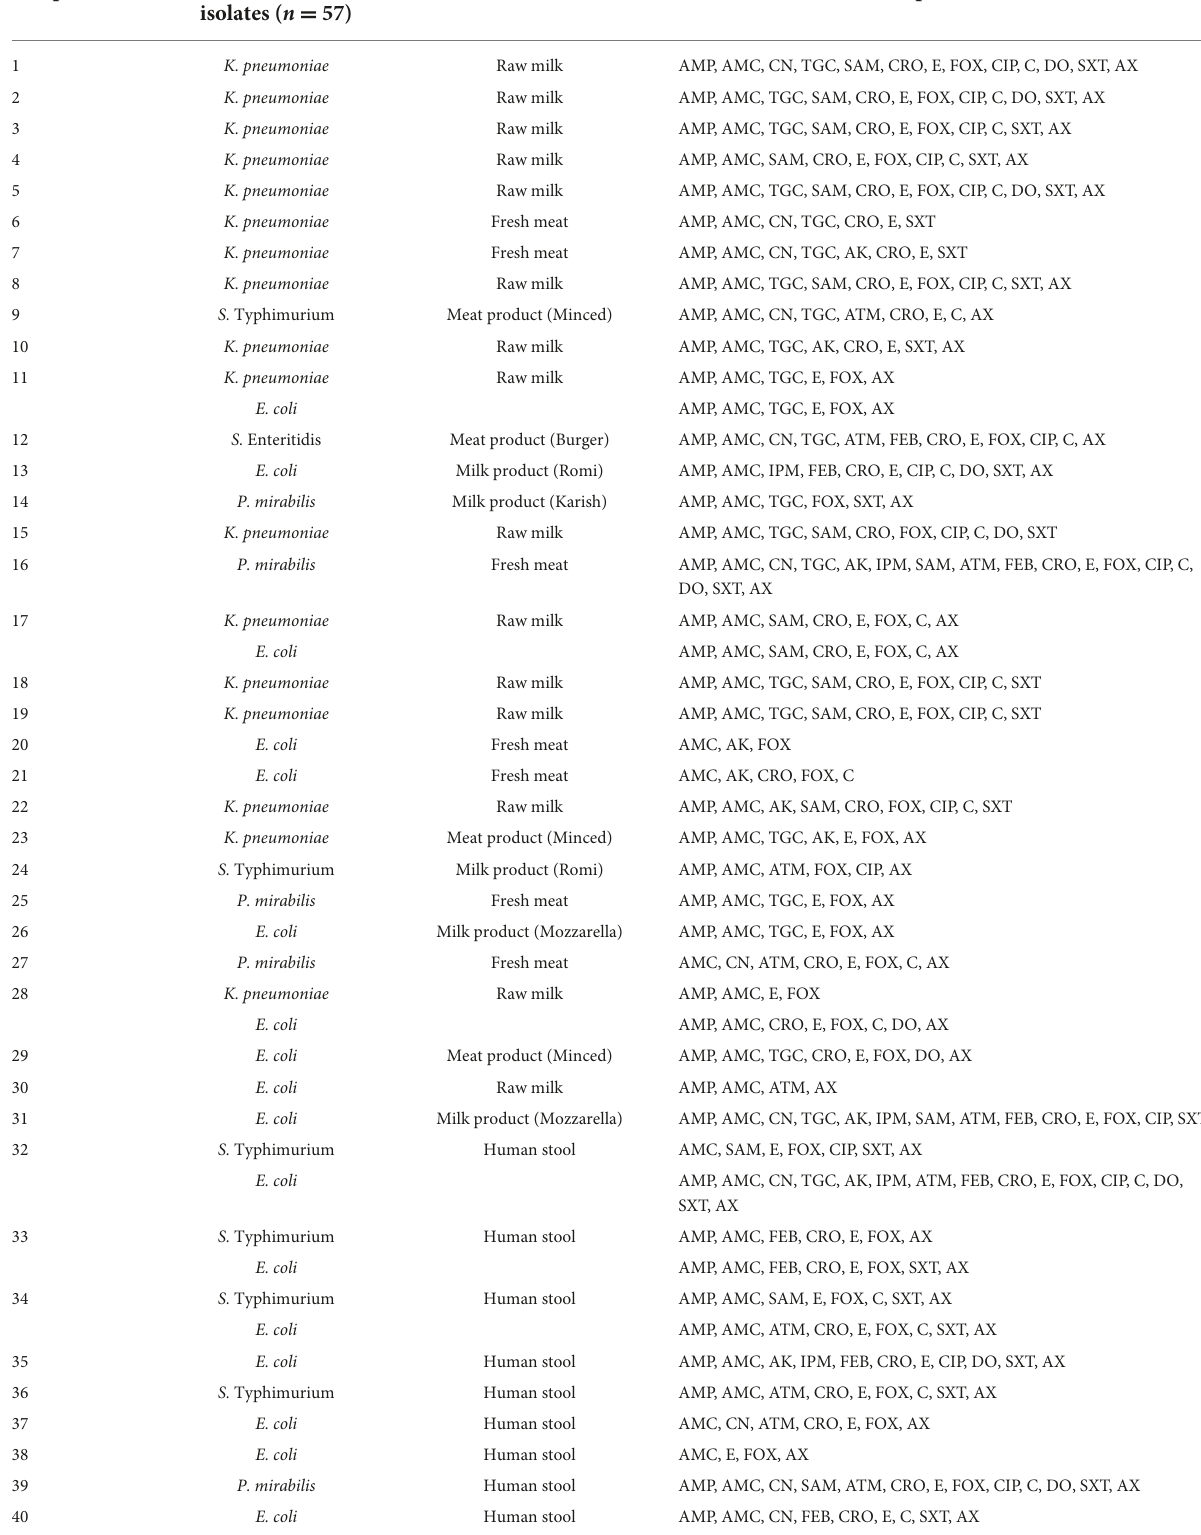
TABLE 3 Antimicrobial resistance patterns of 57 Enterobacterales isolates recovered from 48 samples of animal and human origins. Sample